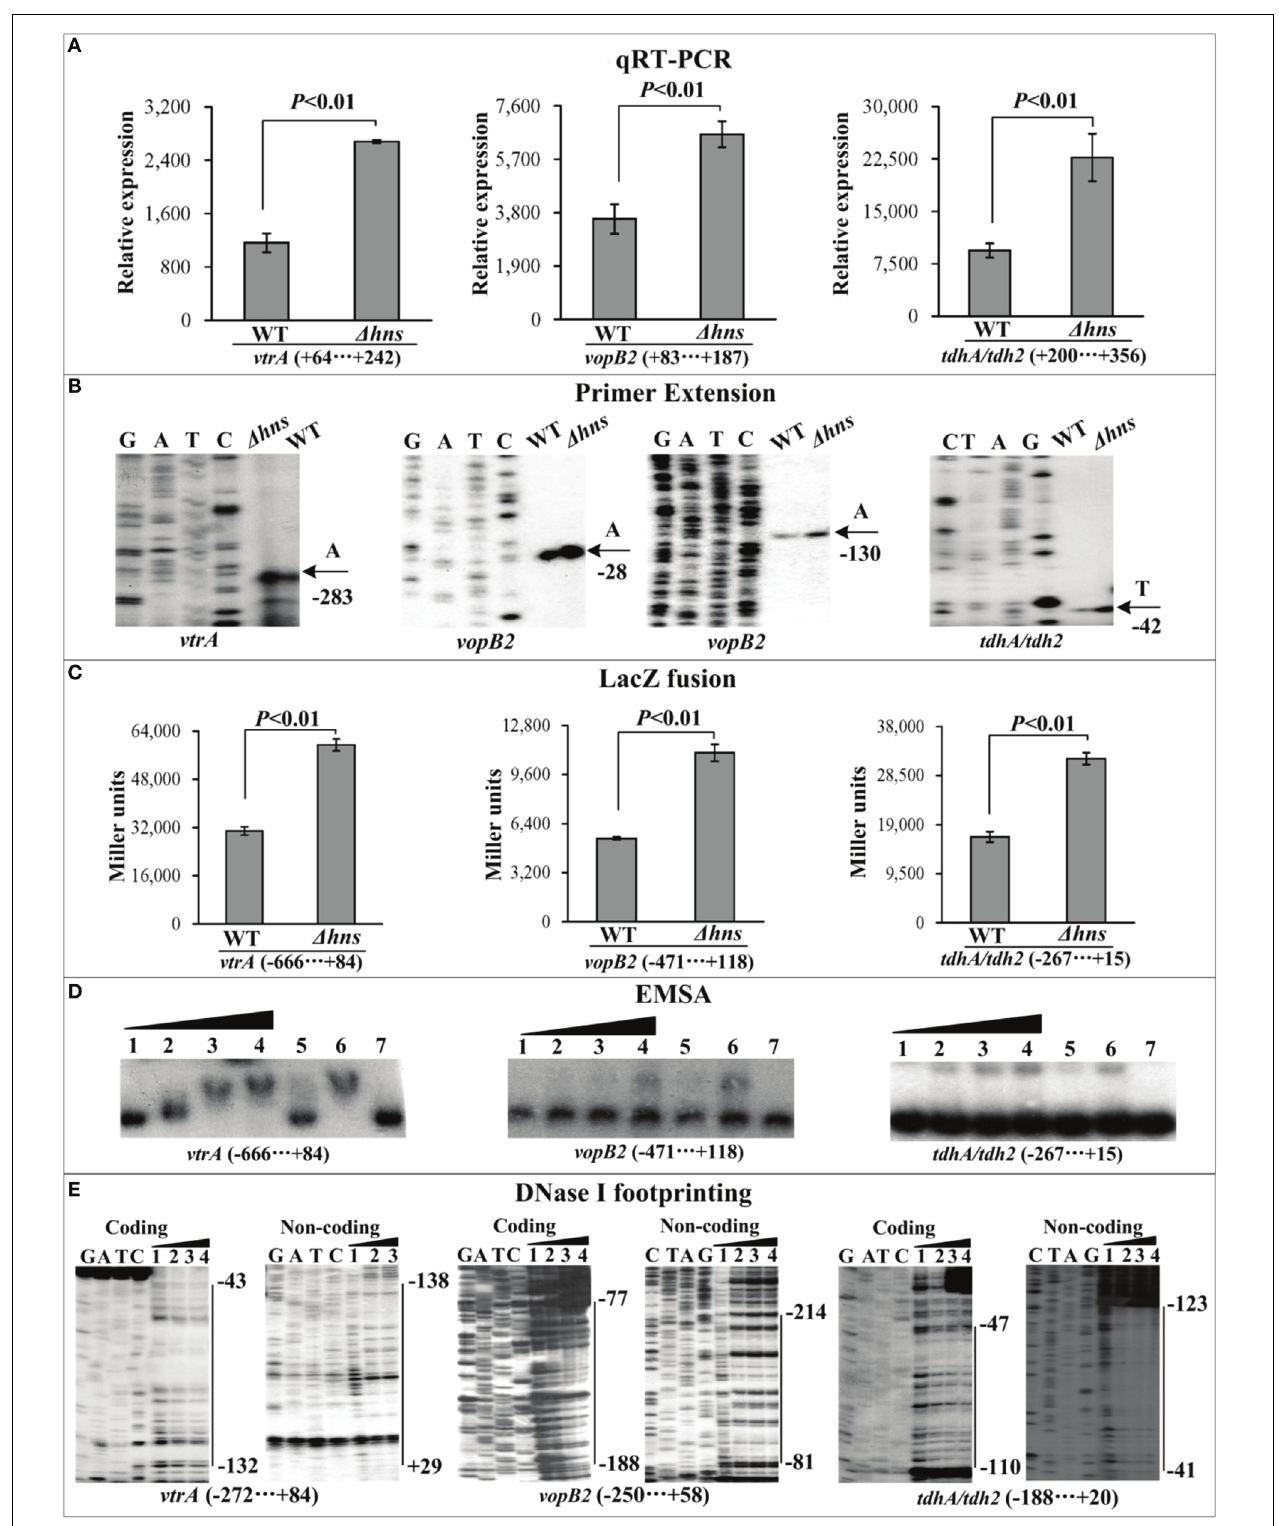
FIGURE 3 | Regulation of Vp-PAI genes by H-NS. qRT-PCR (A) , primer extension (B) , LacZ fusion (C) , EMSA (D) , and DNase I footprinting (E) were performed as Figure 2